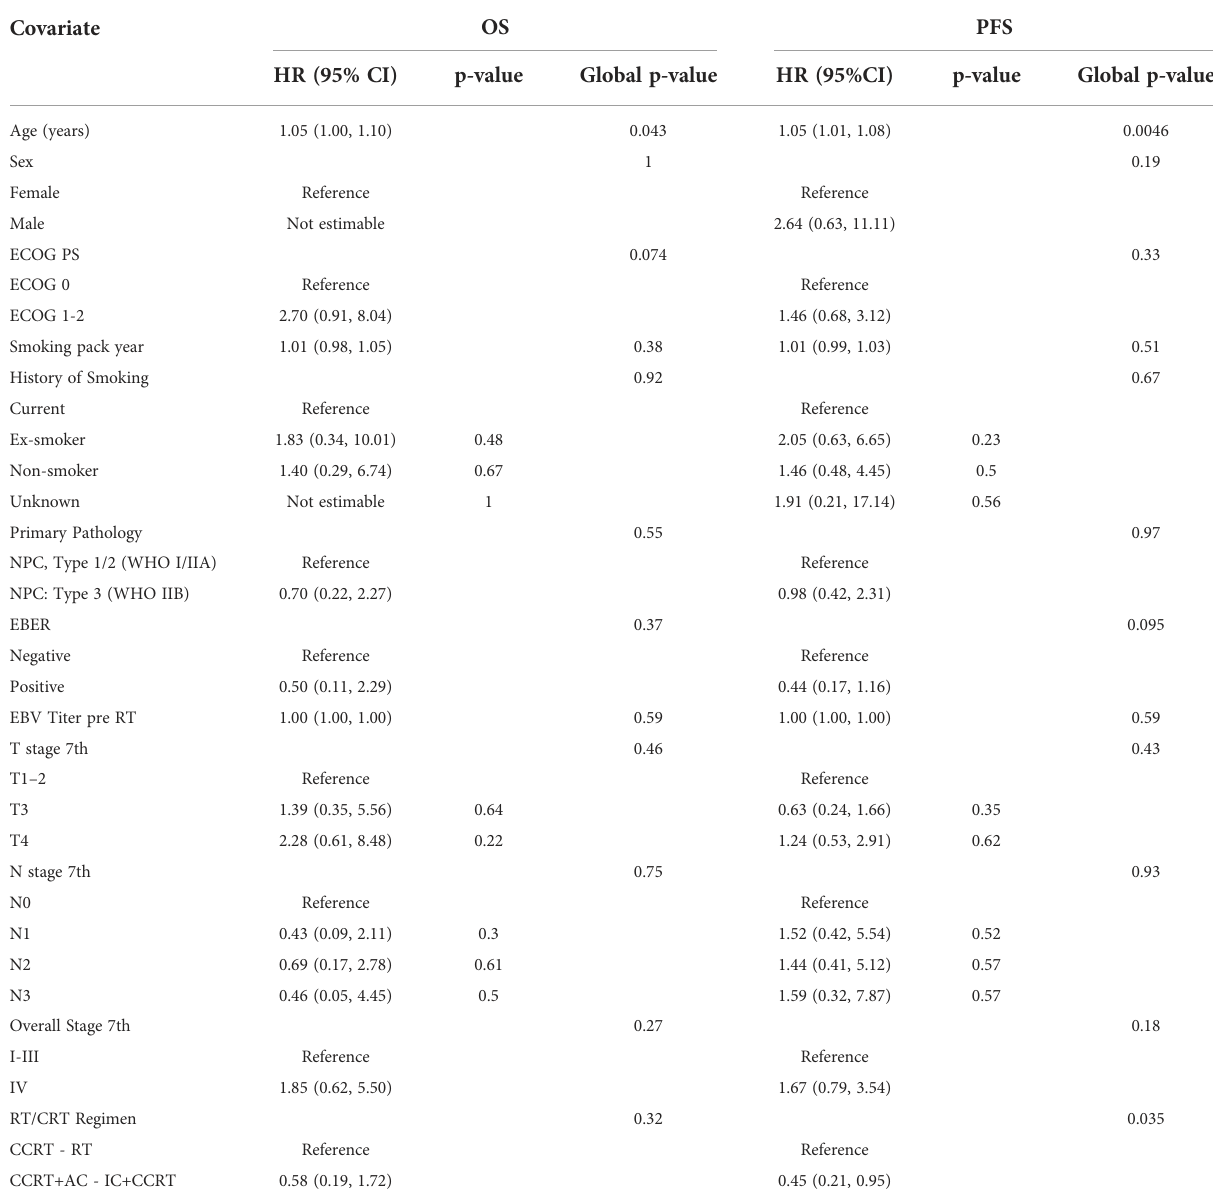
TABLE 2 Univariable analysis of clinical